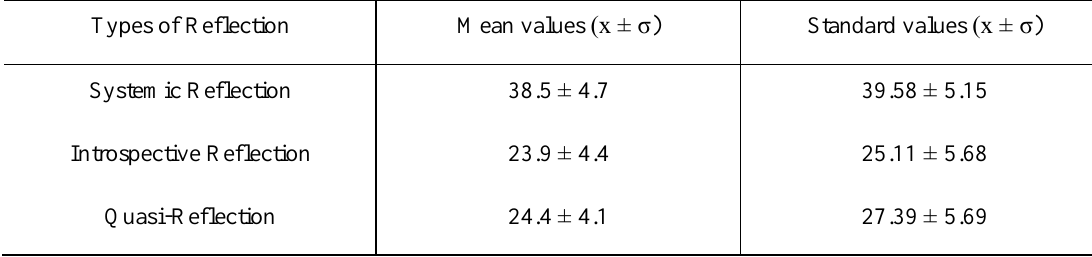
Table 1. Analysis of the Mean Values for Types of